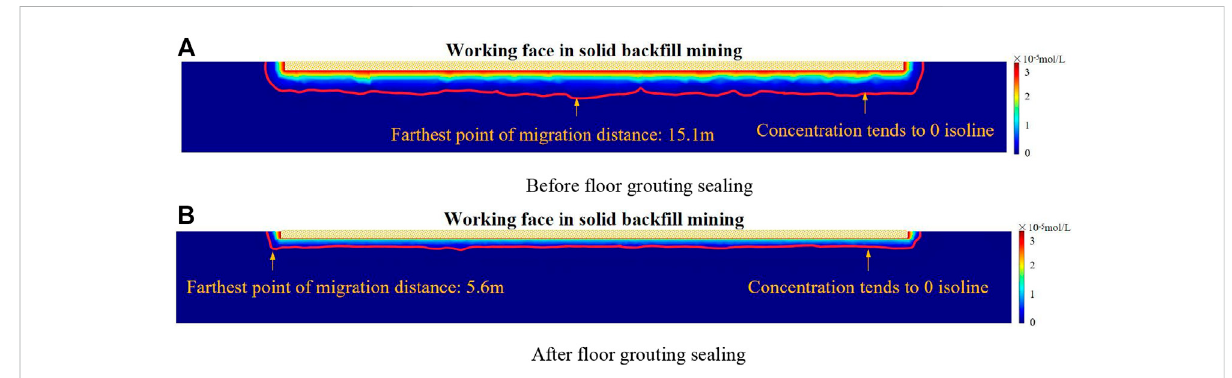
FIGURE 10 The distribution cloud diagram of Mn ion concentration before and after fl oor grouting sealing. (A) Before fl oor grouting sealing (B) After fl oor grouting sealing.